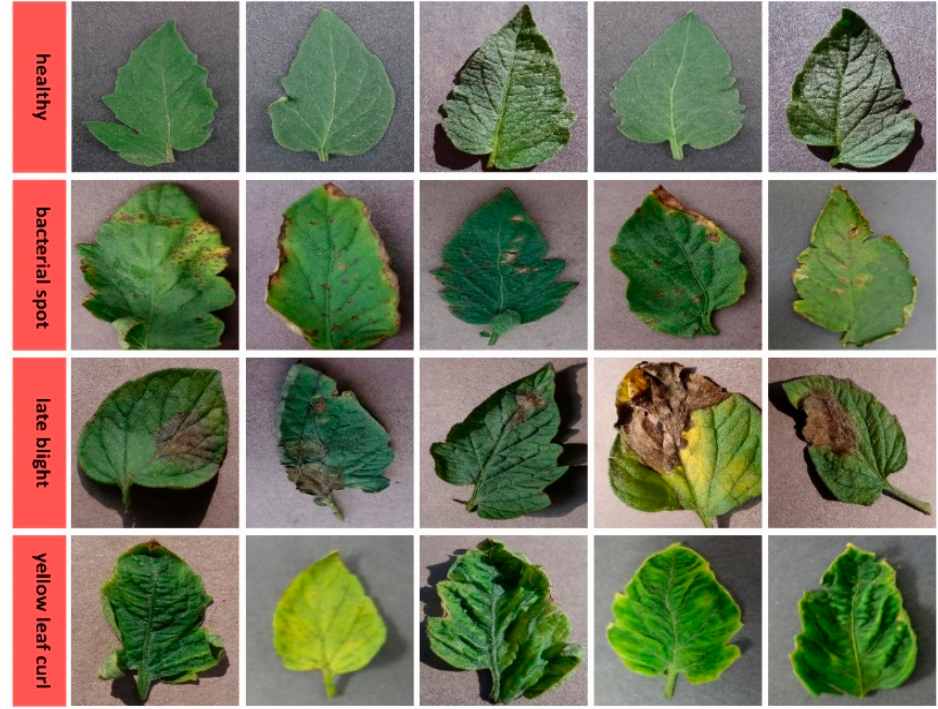
Figure 5. Leaf image examples belonging to healthy and diseased classes of tomato plants.